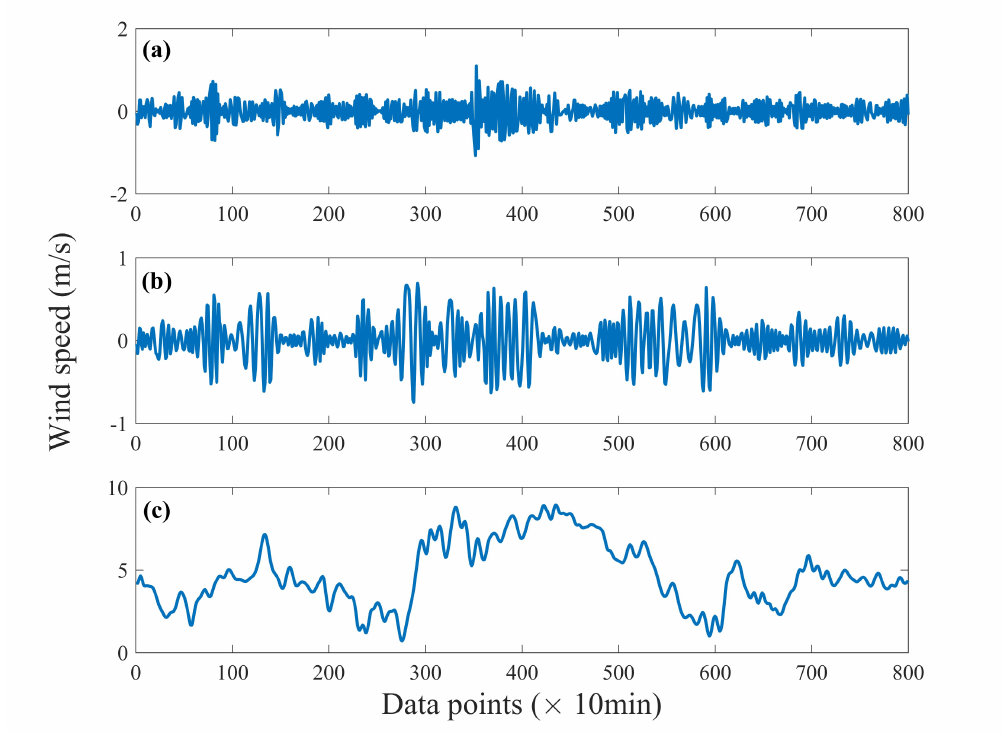
Figure 5. EMD results of 10 min data at the AH site: ( a ) high-frequency intrinsic mode function (HIMF); ( b ) medium-frequency intrinsic mode function (MIMF) and ( c ) low-frequency residuals